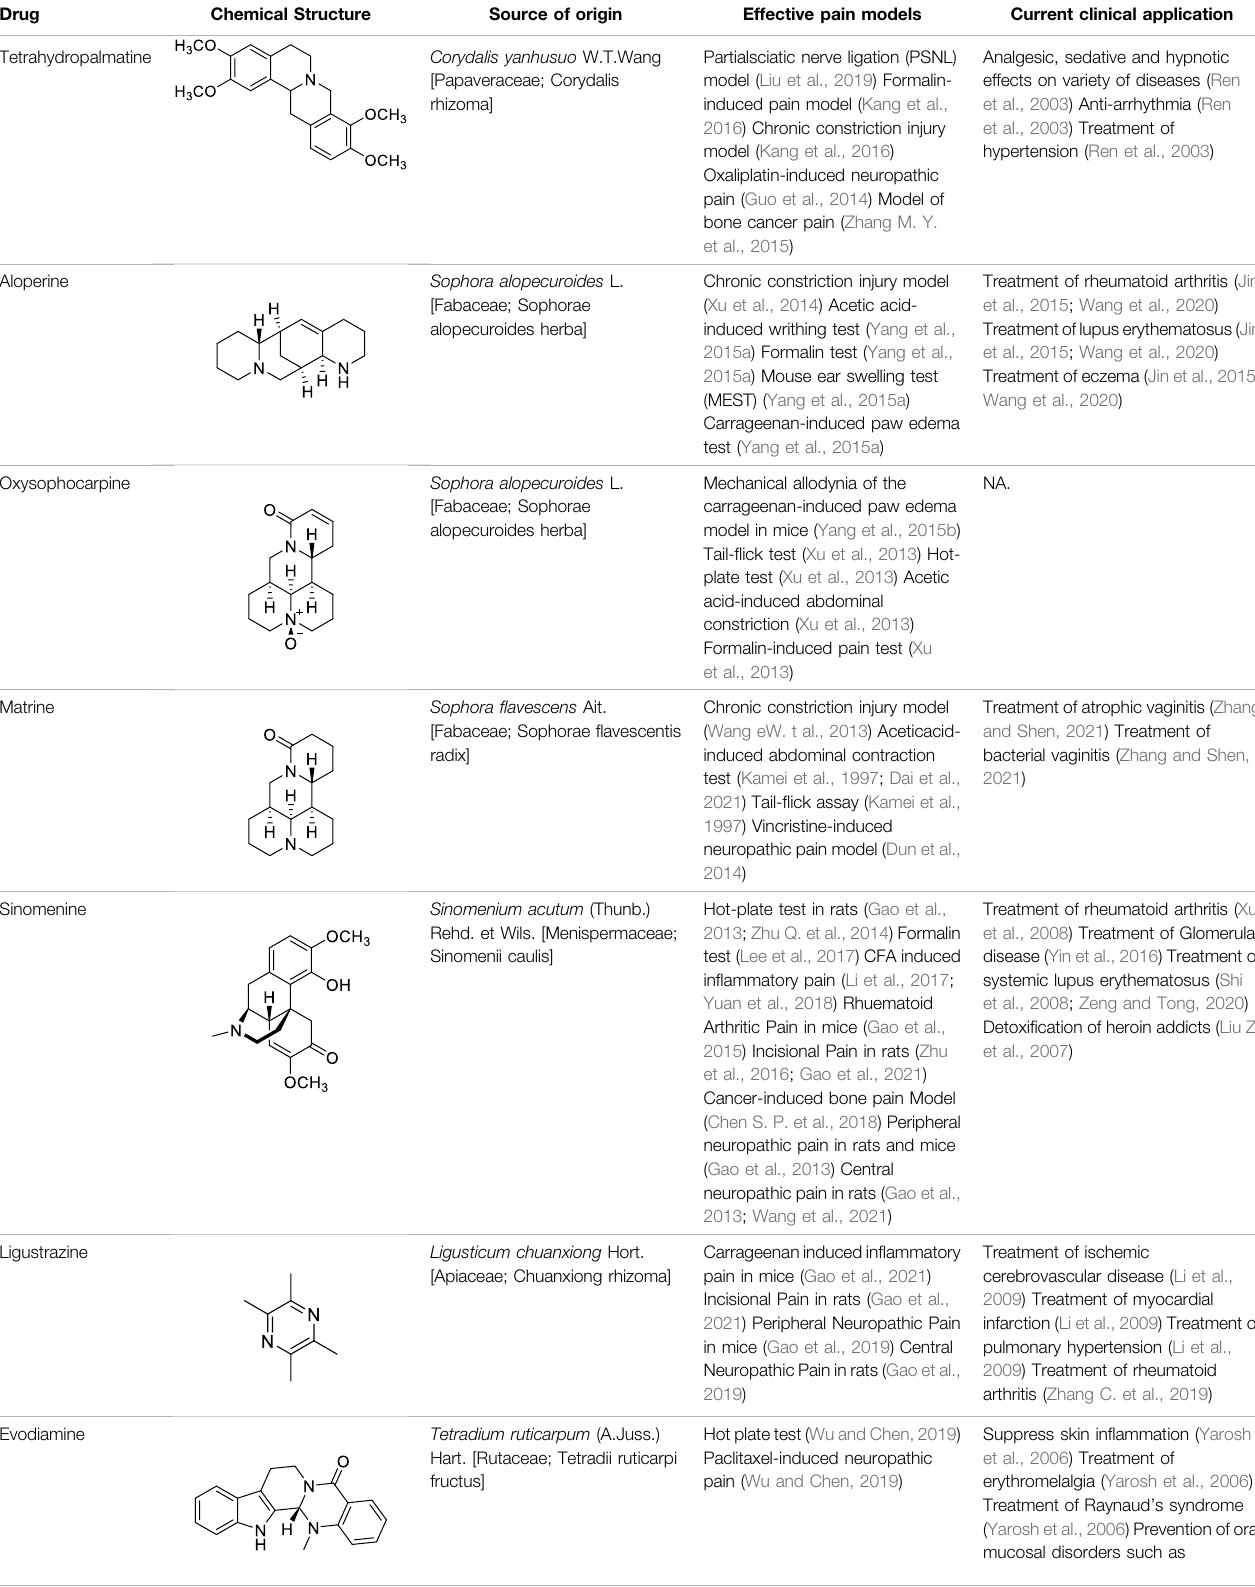
TABLE 1 | Introduction of TCM derived analgesic